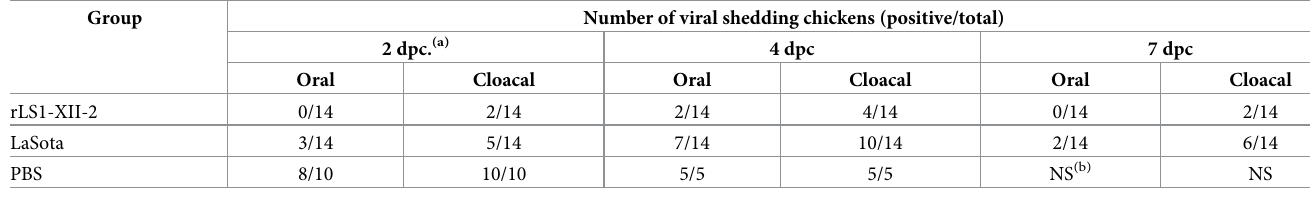
Table 3. Frequency of isolation of challenge virus in vaccination groups.